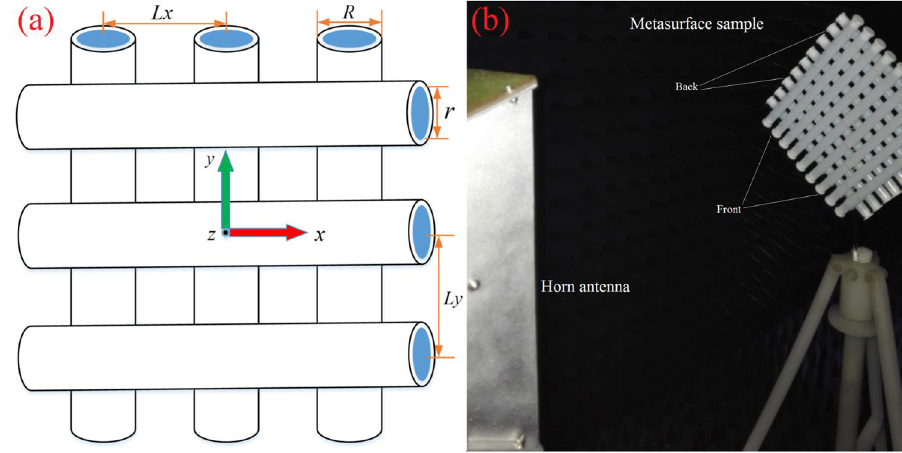
Figure 1. ( a ) Schematic of the unit cell of teflon tubes. ( b ) Photograph of the experimental